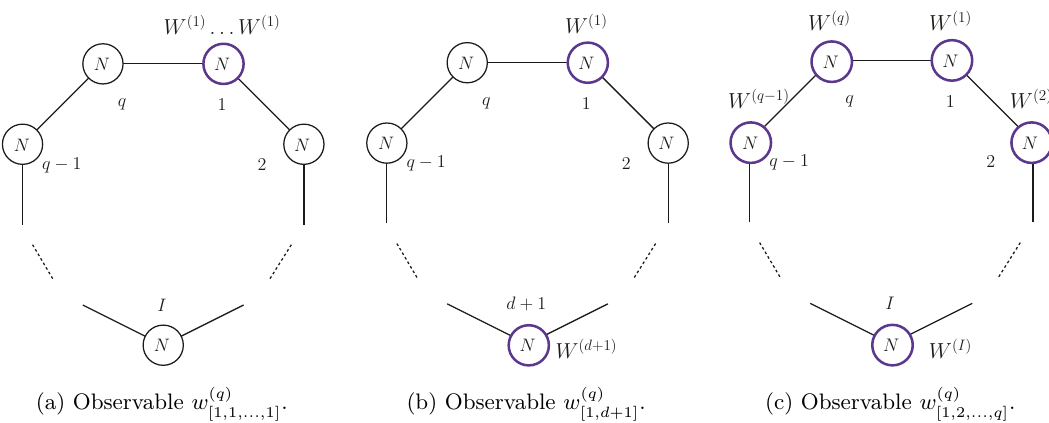
Figure 2 . Multiple insertions of coincident Wilson loops in different nodes. On the left multiple Wilson loops in the same node, at the center two Wilson loops in two nodes with a distance d , on the right q Wilson loops, all belonging to different